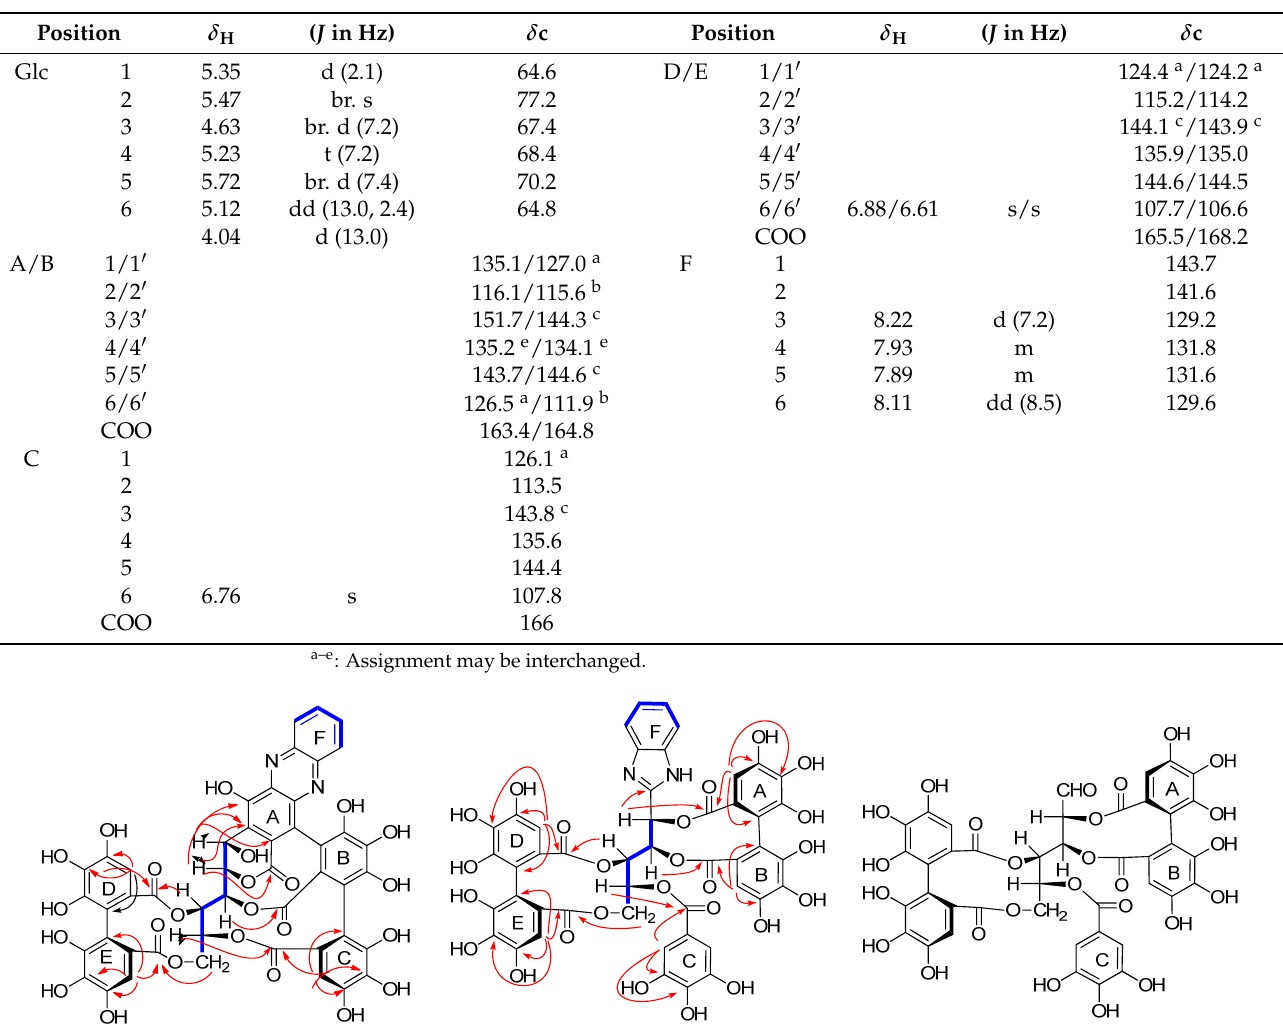
Table 1. 1 H (500 MHz) and 13 C (126 MHz) NMR data of 6 (in acetone- d 6 ).